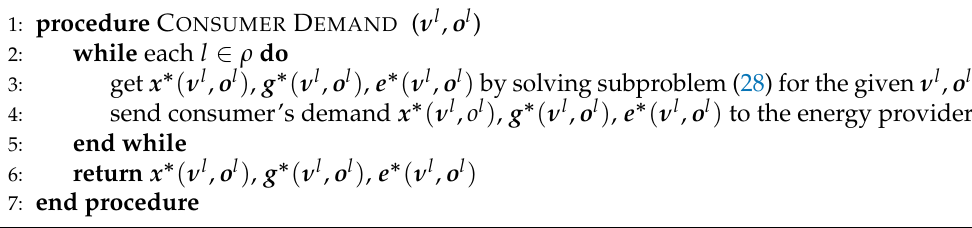
Algorithm 1 Consumer’s Demand Decision Algorithm